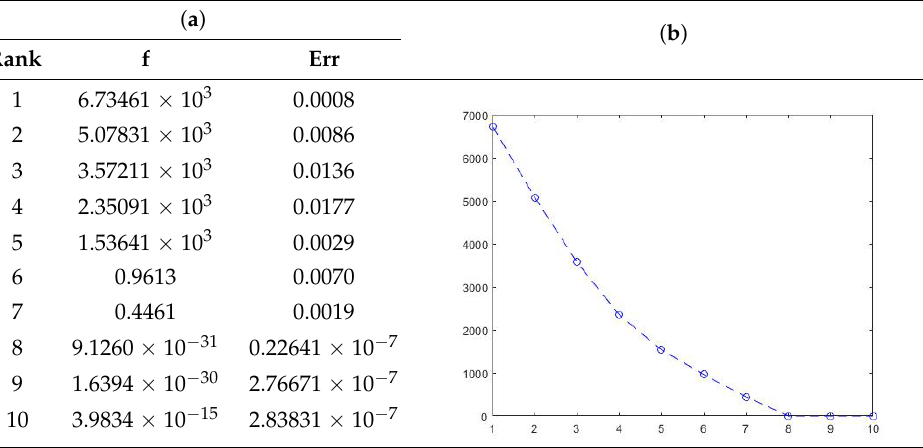
Table 10. The table shows the values of the cost function for different value of the rank and the relative errors. The true rank is 8. The values of the objective for the different ranks are represented on the figure